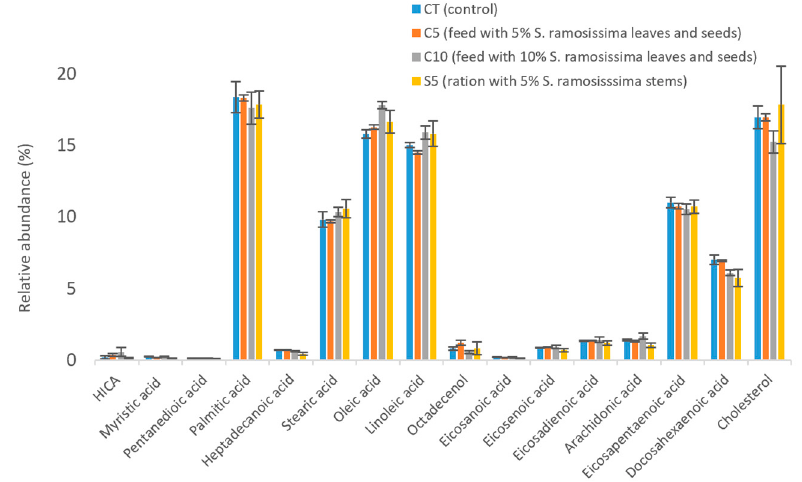
Figure 1. Secondary metabolites identified in Figure 49. Secondary metabolites identified in shrimp.